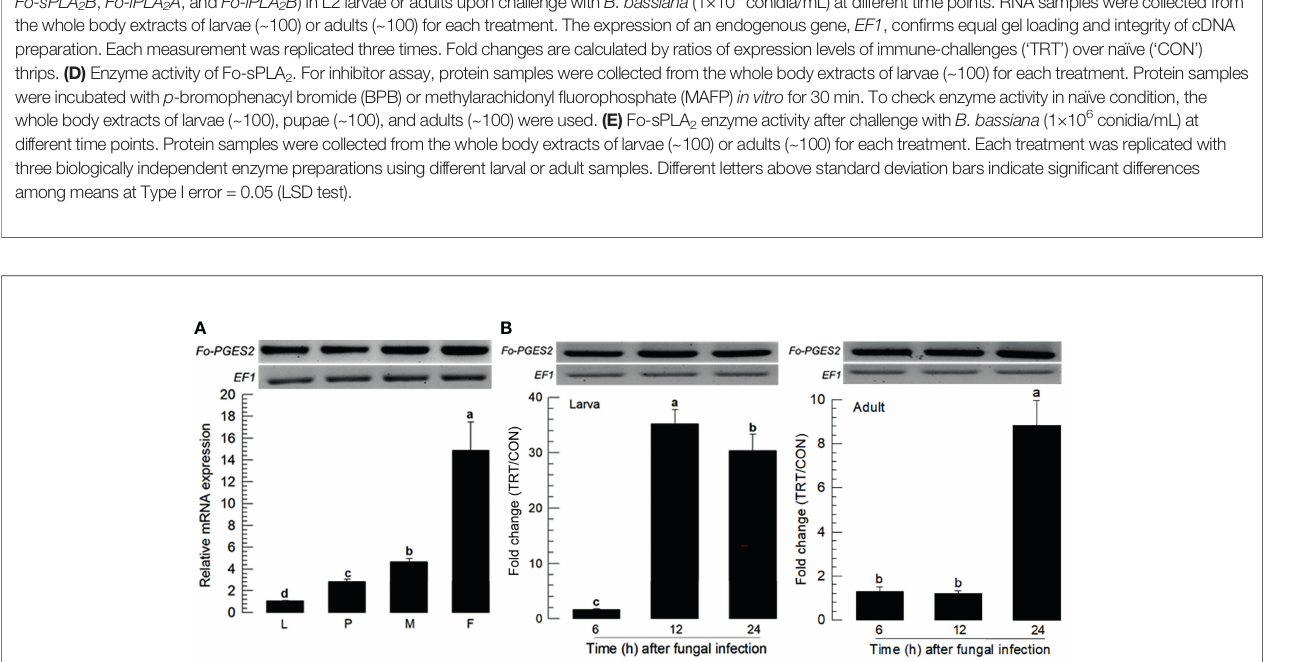
exigua DSP1 reacted with DSP1 of F. occidentalis and allowed us